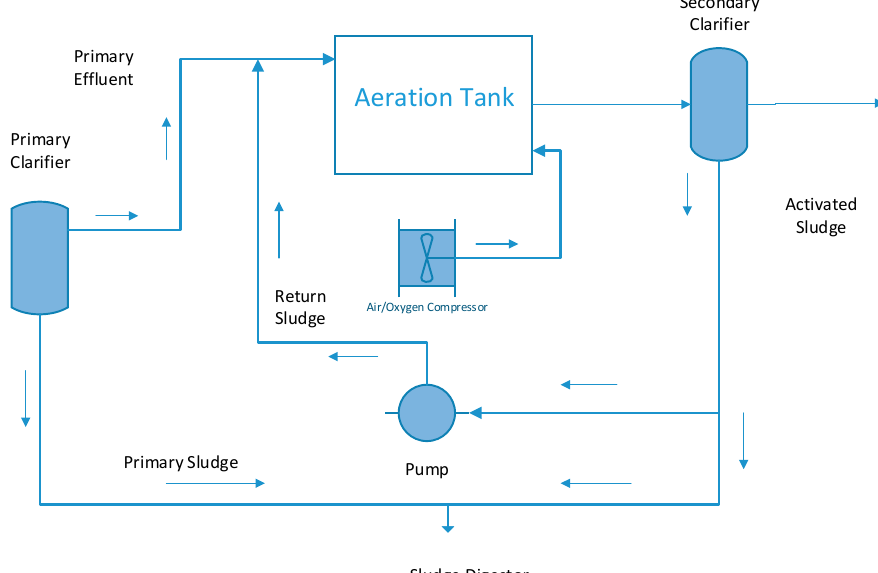
Figure 4. Schematic of secondary treatment process